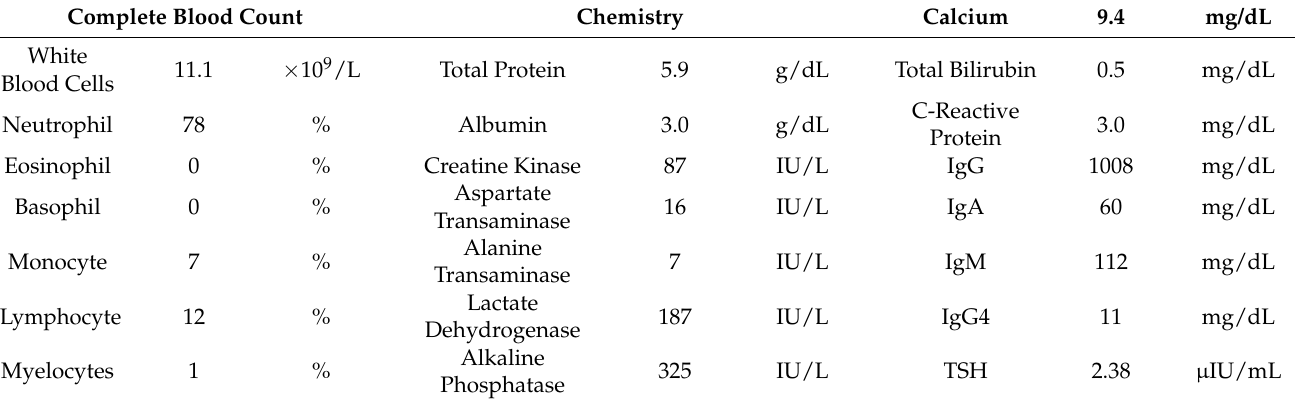
Table 1. Laboratory data of our patient with TAFRO syndrome at the transfer to our hospital. Complete Blood